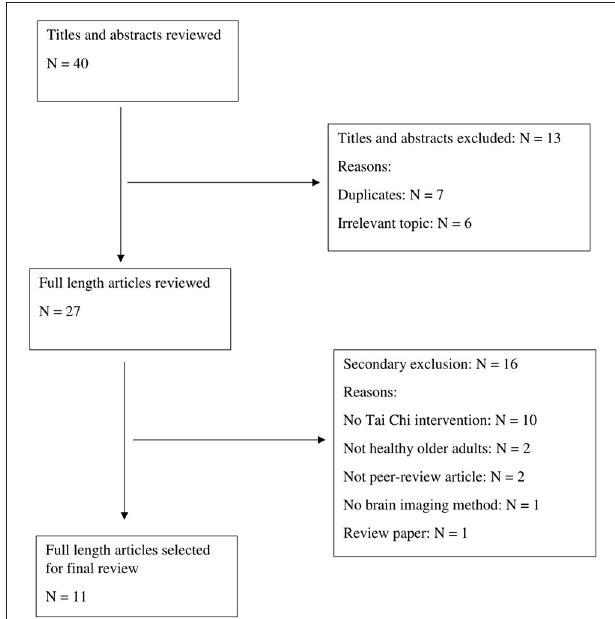
FIGURE 1 | Article selection